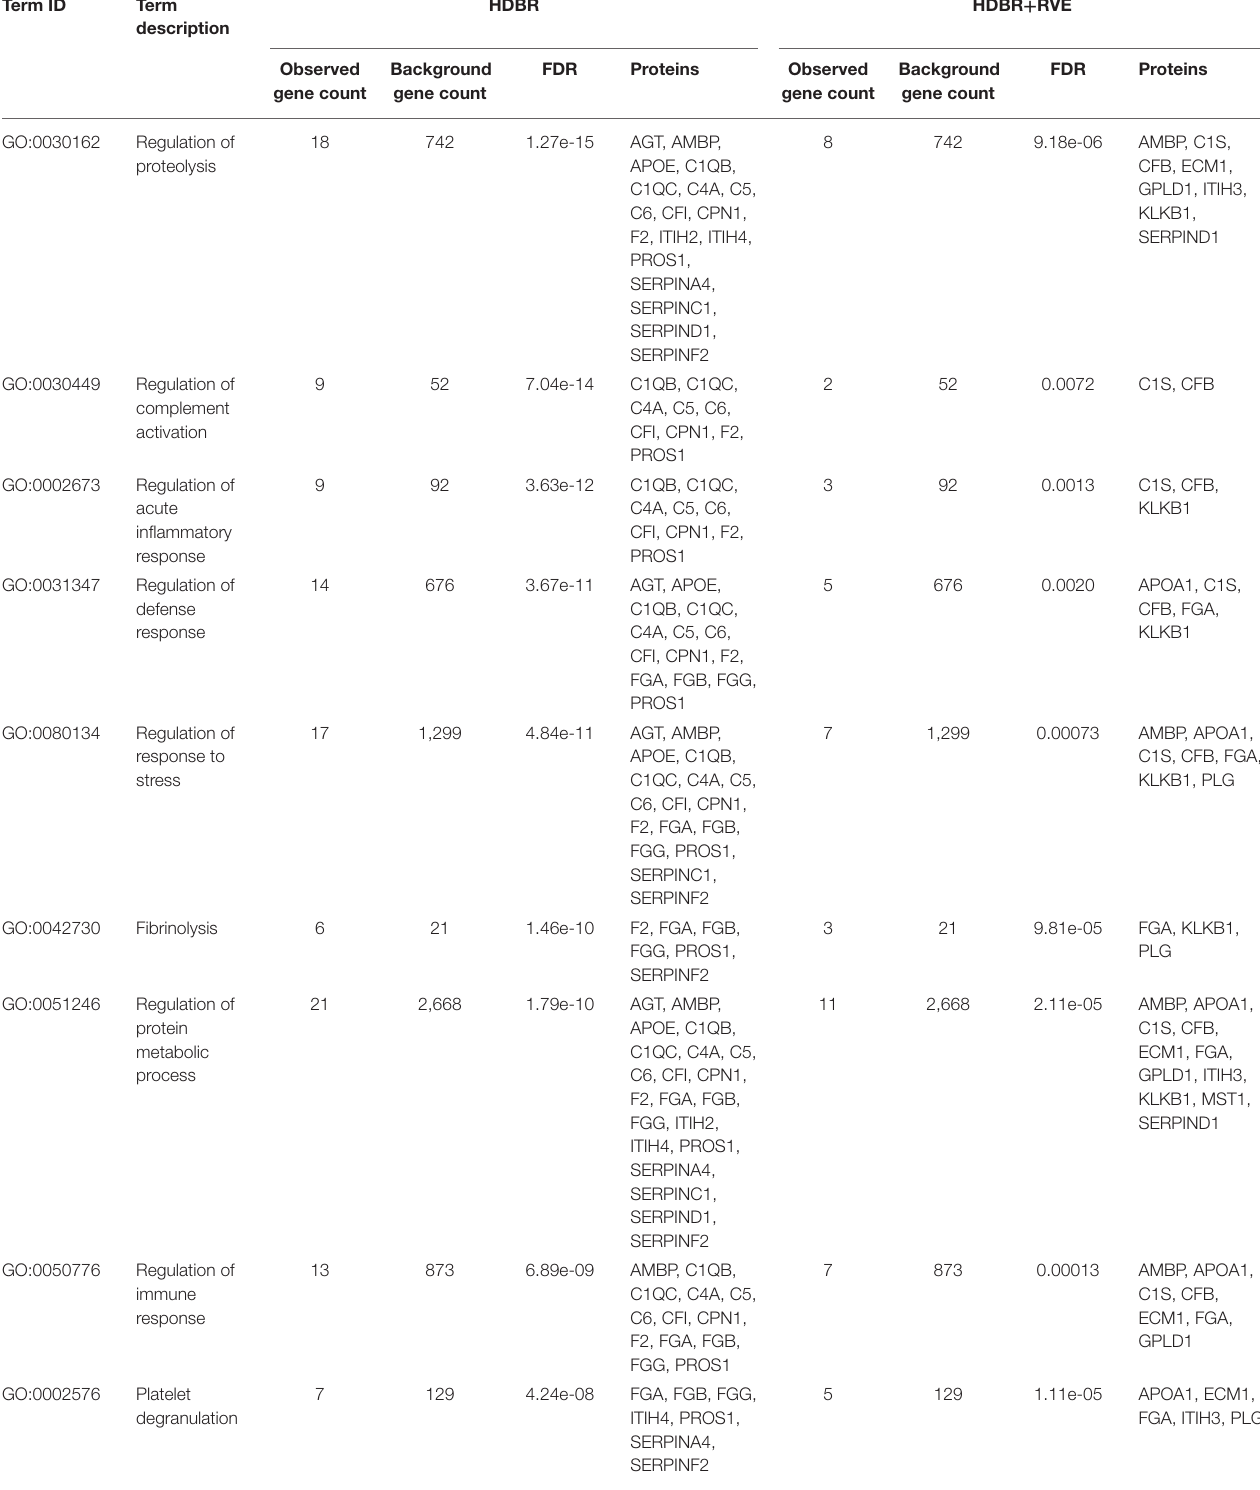
TABLE 2 | Comparison of the biological processes enriched in two sessions of head-down bed rest (HDBR). Term ID Term HDBR HDBR + RVE description Observed Background FDR Proteins Observed gene count gene count